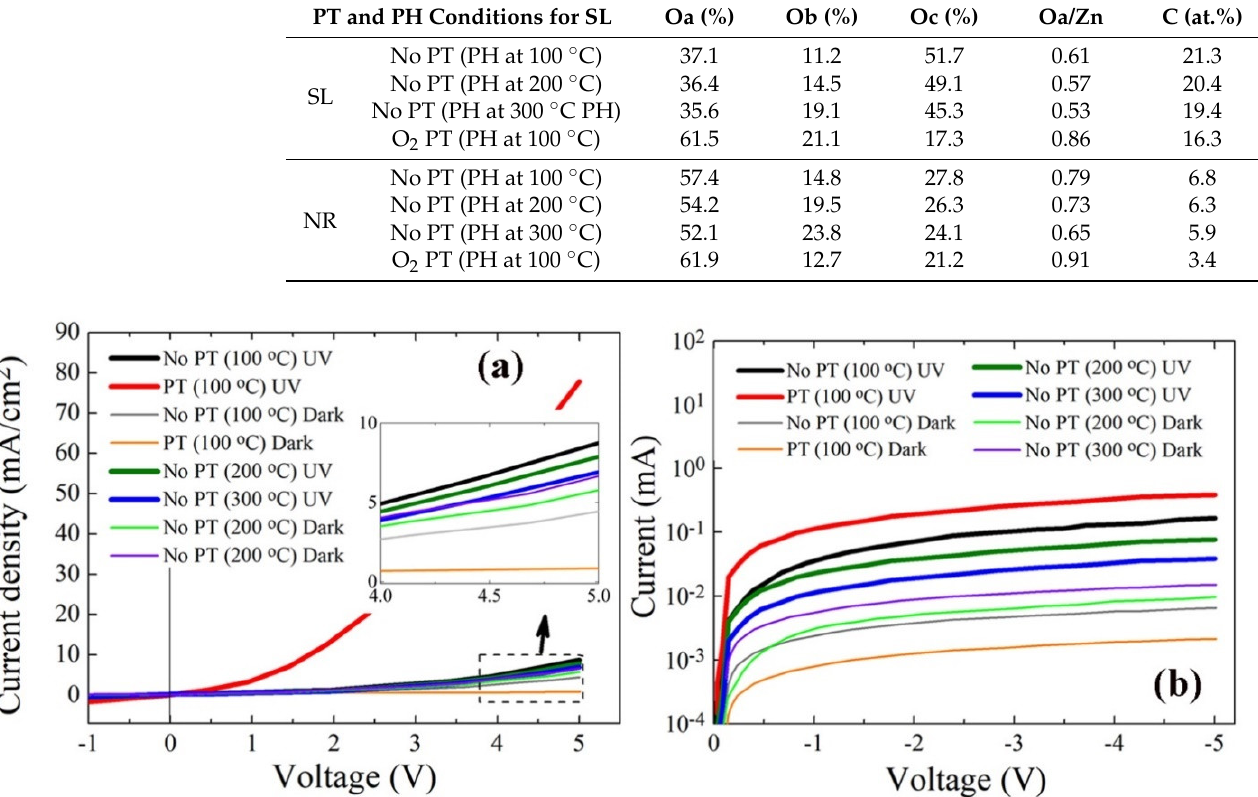
Figure 7. Typical diode photoresponse I − V characteristics of p-Si/n-ZnO NRs grown on the SLs prepared under different conditions according to UV illumination on/off in a forward bias range of −1 ± 5 V ( a ) and a reverse bias range of −5–0 V ( b ). Table 4. Summary photocurrents, dark currents, and on-off current ratios at bias conditions of +5 and −5 V measured from the p-Si/n-ZnO-NR heterojunction PDs. Parameter PT and PH conditions for SLs Forward bias (+5 V) Reverse bias (−5 V)